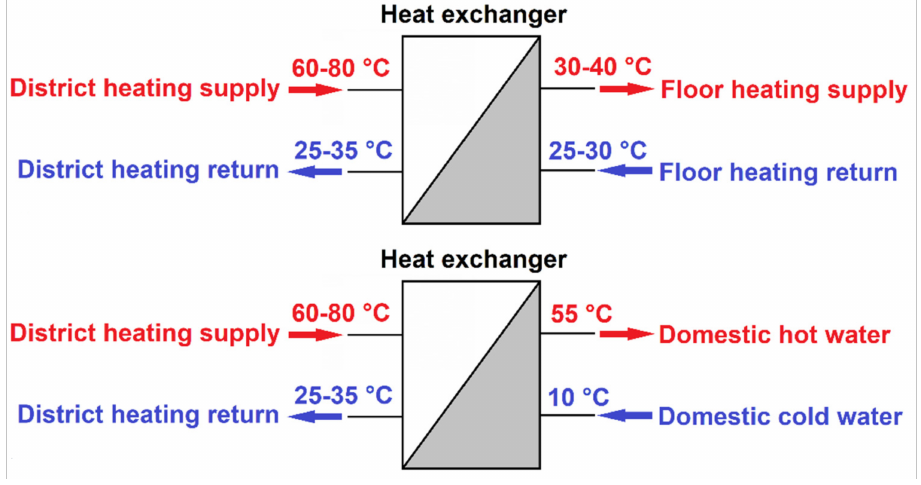
Figure 10. Example of low temperatures in a district heating circuit interfaced via heat exchangers to underfloor heating and domestic hot water circuits. Modified after